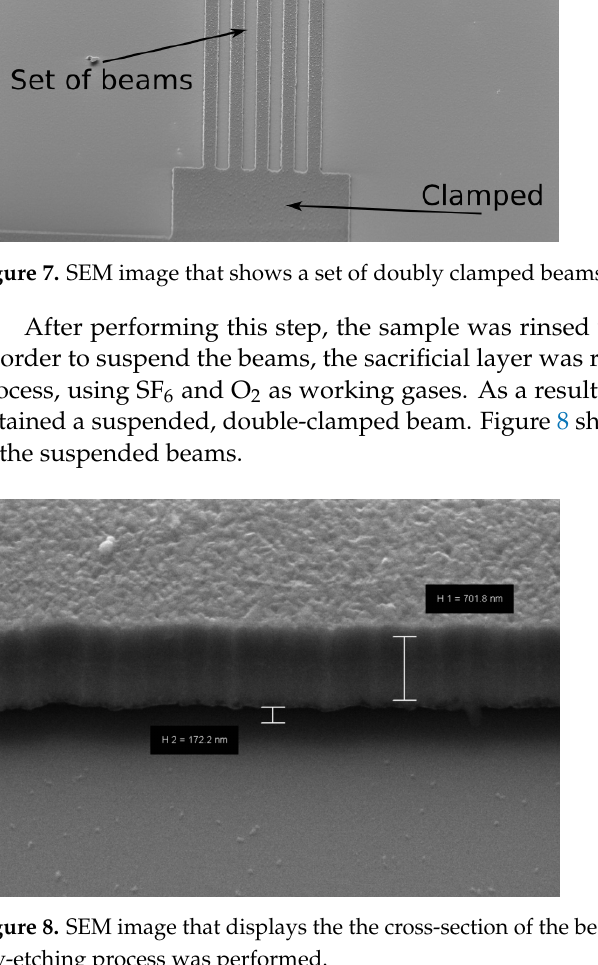
Figure 8. SEM image that displays the the cross-section of the beam successfully suspended, once the dry-etching process was